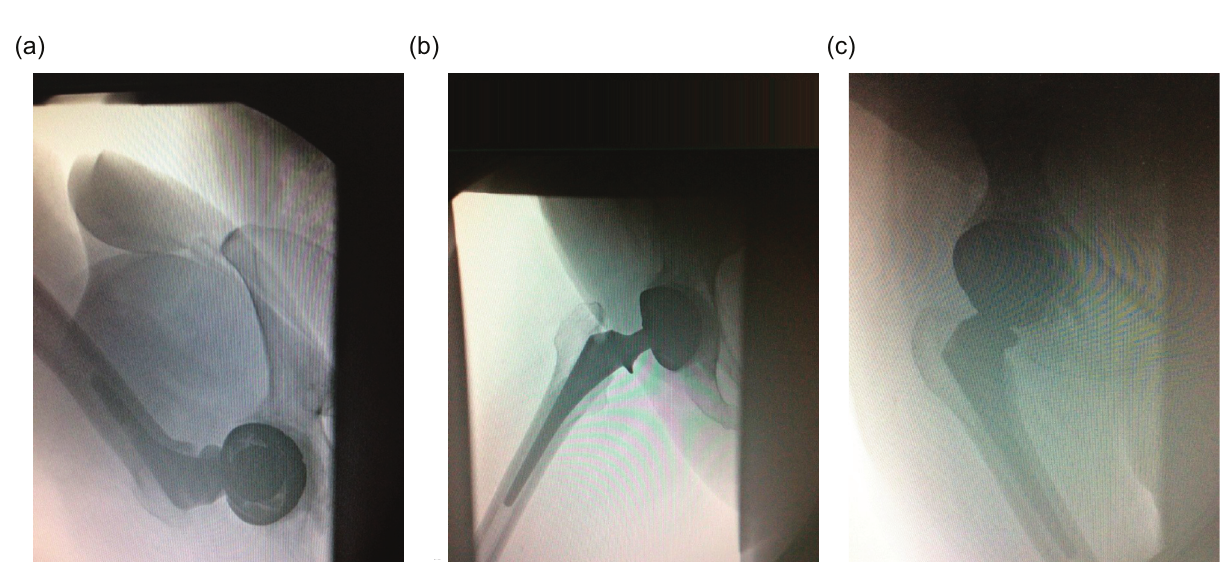
Figure 4. Fluoroscopic examination of a dual mobility THR in (a) flexion, (b) abduction and (c)